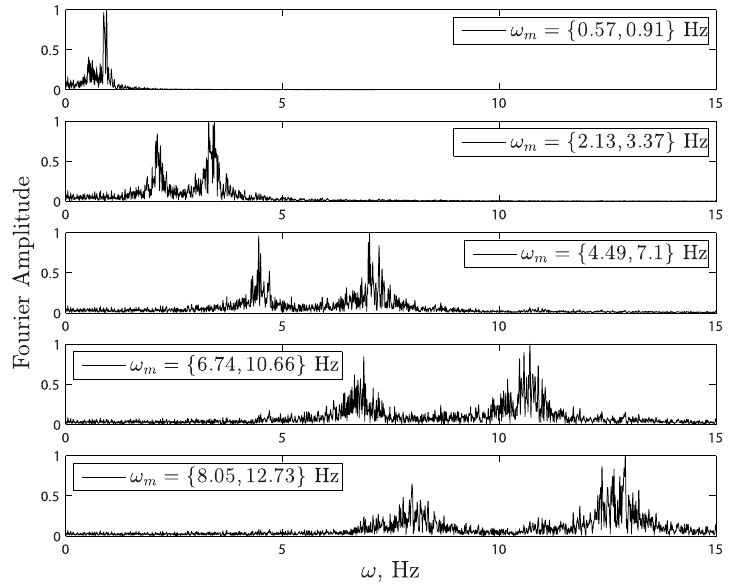
Fig. 6. Fourier spectra of the separated sources using SOBI